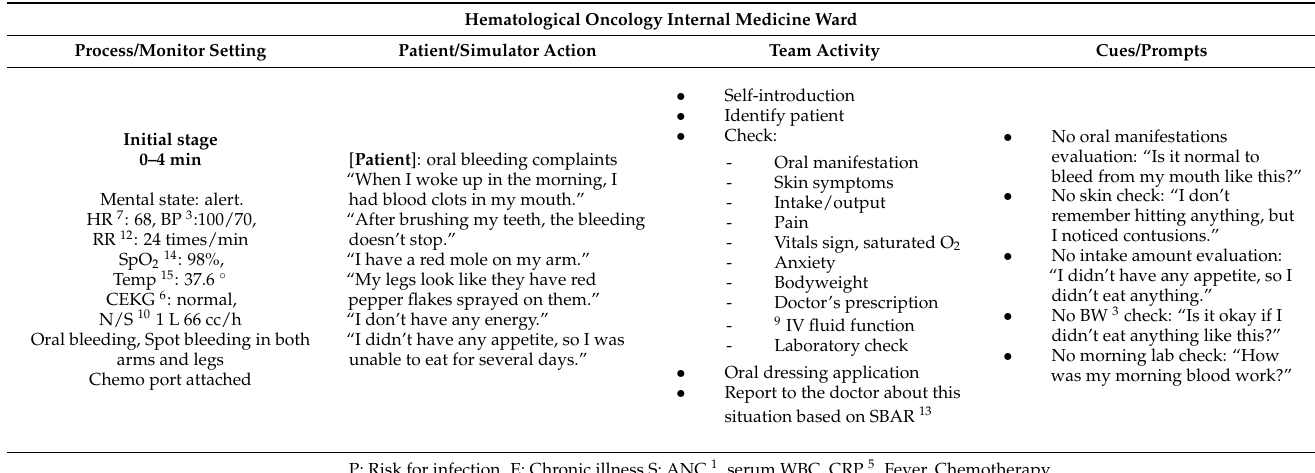
Table 1. Simulation set: Continuous bleeding in the mouth after brushing teeth. Hematological Oncology Internal Medicine Ward Process/Monitor Setting Patient/Simulator Action